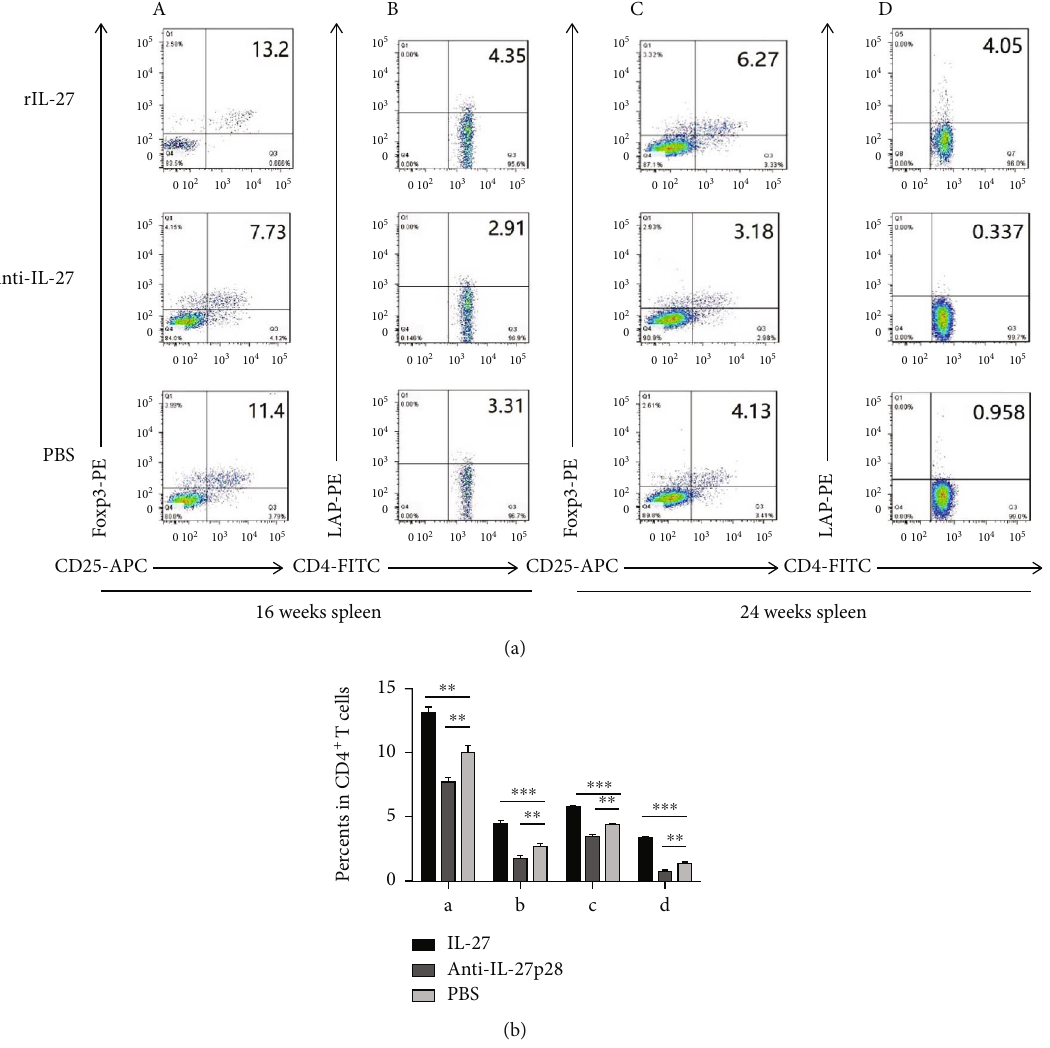
Figure 3: Recombinant IL-27 elevated the generation of Foxp3 + and LAP + Tregs in the spleen of ApoE -/- mice. (a) In the spleen, the fractions of Foxp3 + and LAP + Tregs were measured by fl ow cytometry. (a) and (b) show the fractions of Foxp3 + Tregs (A) and LAP + Tregs (B) during the initiation of atherosclerosis. (C) and (D) show the fractions of Foxp3 + Tregs (C) and LAP + Tregs (D) during the progression of atherosclerosis. (b) Groups data are shown in histogram. ∗∗∗ P < 0 : 001 , ∗∗ P < 0 : 01 , ∗ P < 0 : 05